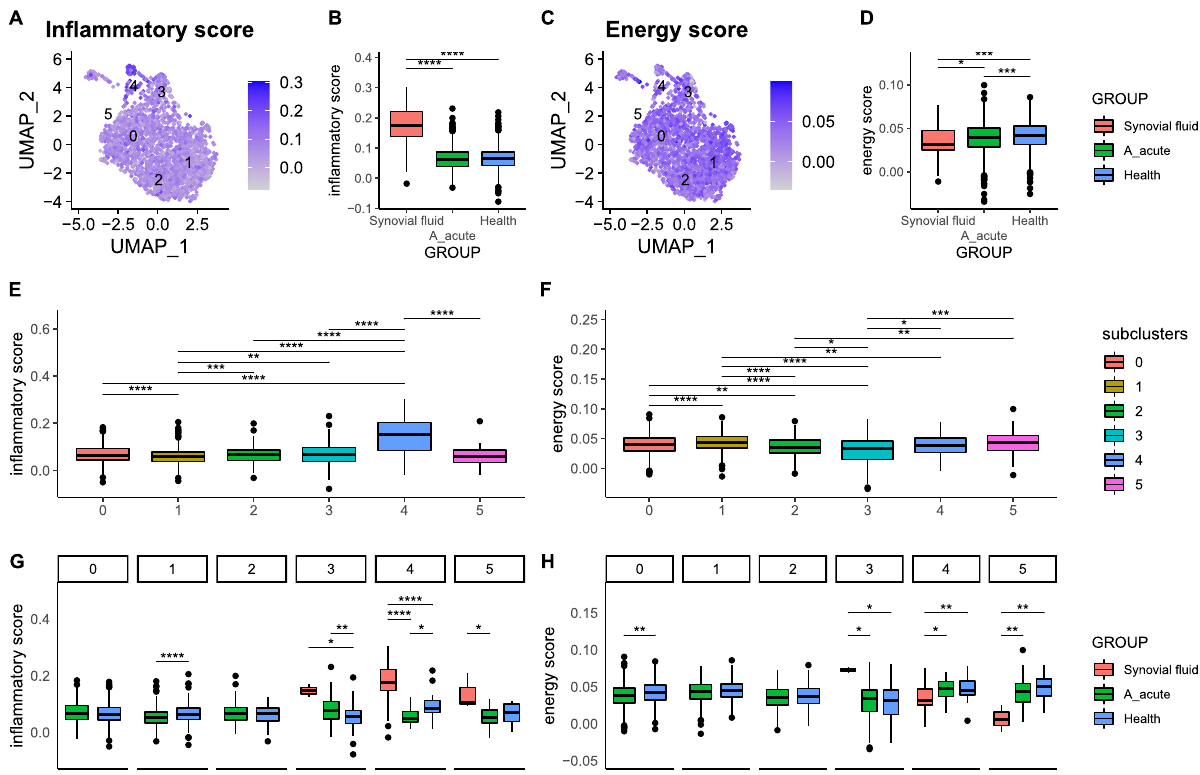
Figure 4. Inflammation score (IS) and energy score (ES) of intermediate monocytes. ( A – D ) Intermediate monocyte IS and ES values are shown on UMAP coordinates. Boxplots show scores among SF (red) and PBMC samples for acute gout (green) and health (blue) subject groups. ( E , F ) Boxplots of ISs and ESs among subclusters according to cluster labels. ( G , H ) ISs and ESs among SF (red) and PBMC samples for acute gout (green) and healthy (blue) subject groups for each subcluster. (* P < 0.05; ** P < 0.01; *** P < 0.001; **** P <